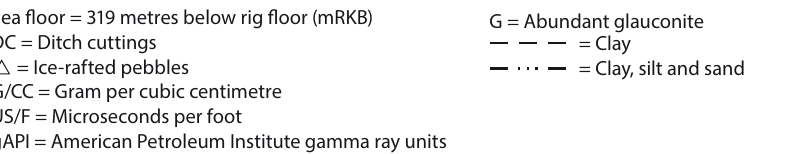
Figure 71. Well summary figure including density log, sonic log, gamma-ray log, lithology, lithostratigraphic units, sub-series, stages, paleobathymetry and analysed samples for the investigated sequence in well 6407/9–5 (Rupelian to Gelasian) including the type well section for the Molo Formation (modified after Eidvin et al., 2007, 2013d and Dybkjær et al.,